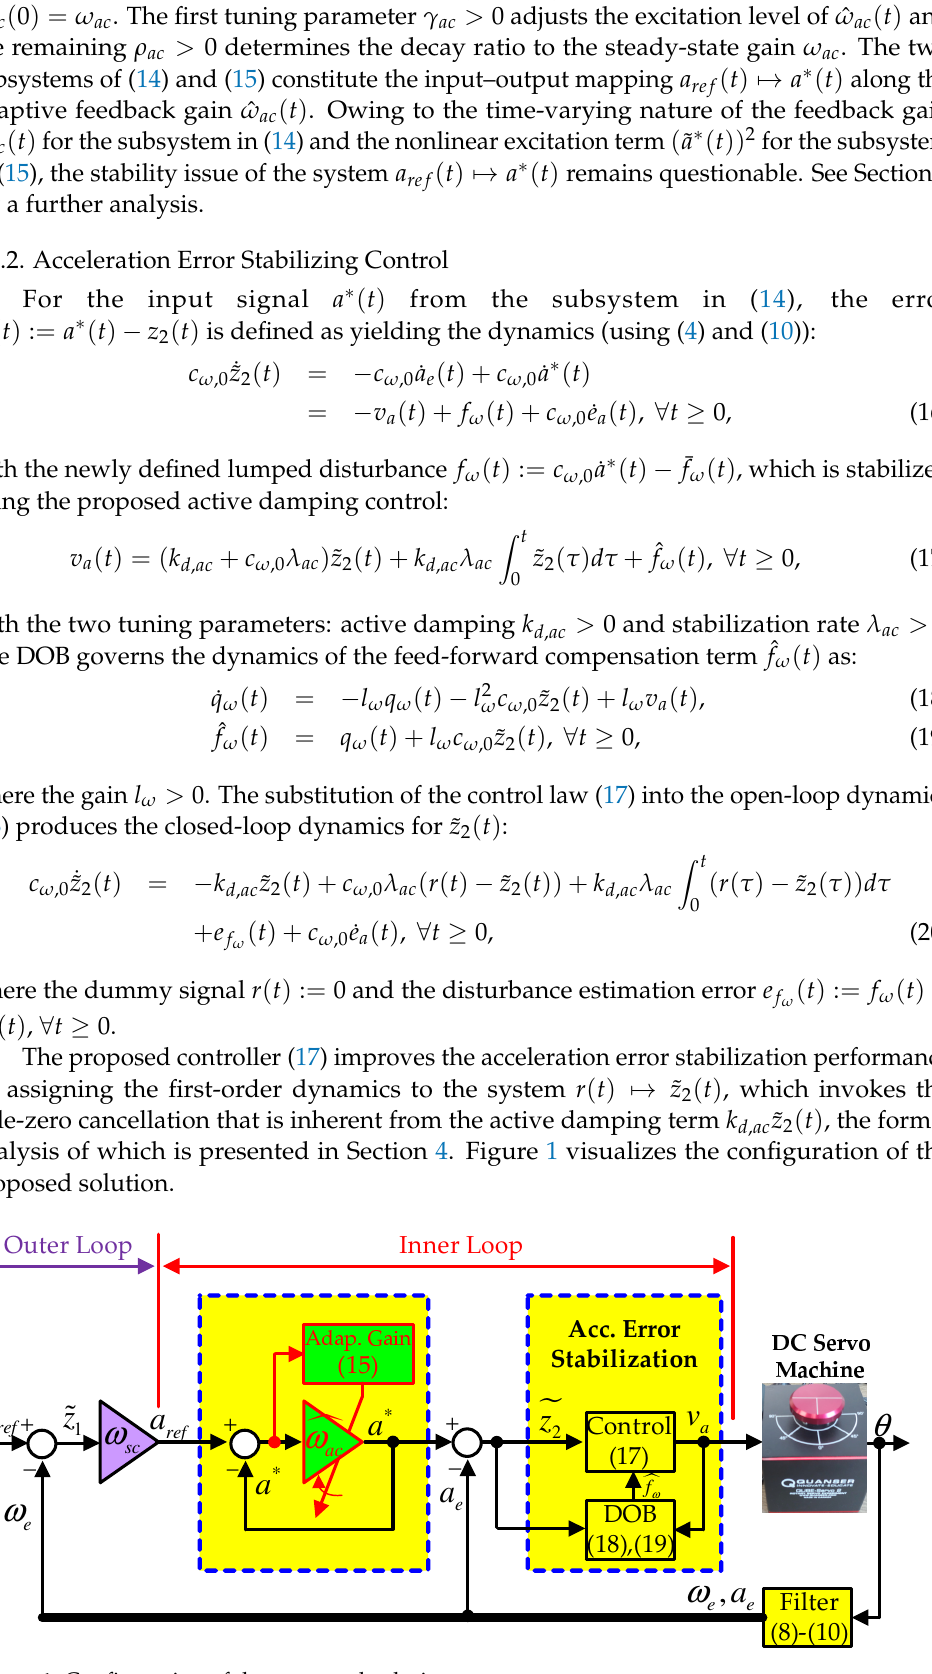
Figure 1. Configuration of the proposed